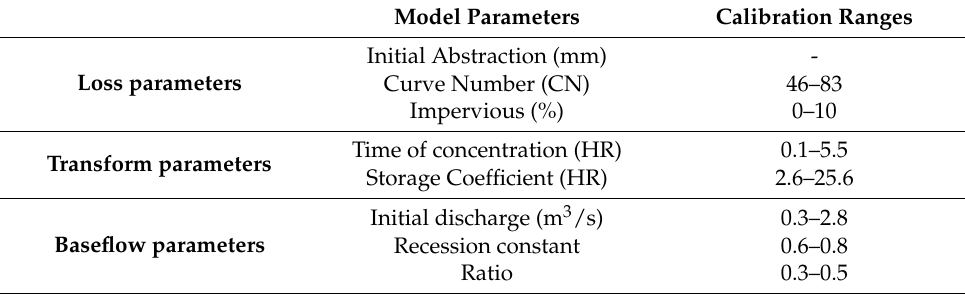
Table 4. Summary range of calibrated parameter values.